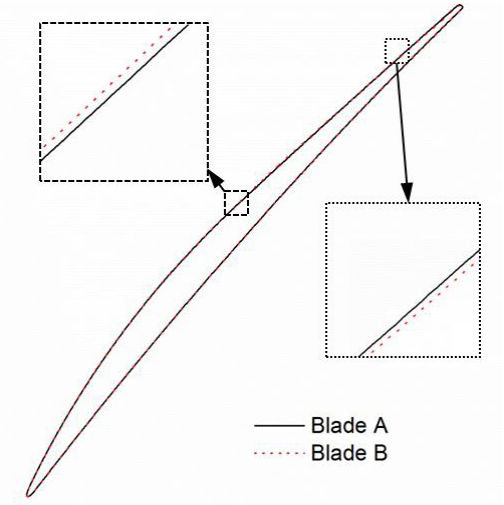
Figure 19. Geometries of Blade A and Blade B (with parts of the suction surface